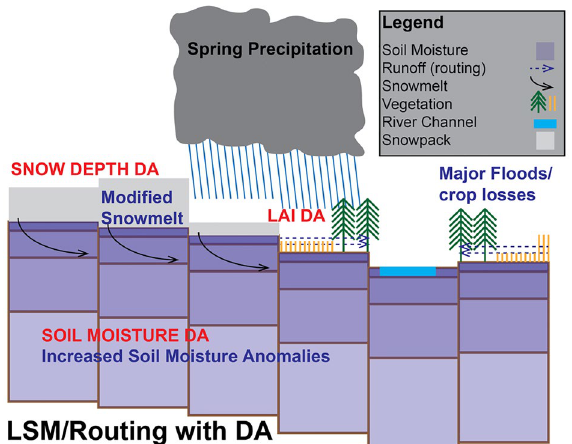
Figure 1. Conceptual illustration of the LSM and Routing Model with the impacts of DA. Physical processes are labeled in blue, while the impacts of DA are labeled in red. This graphic was generated by the authors using Adobe